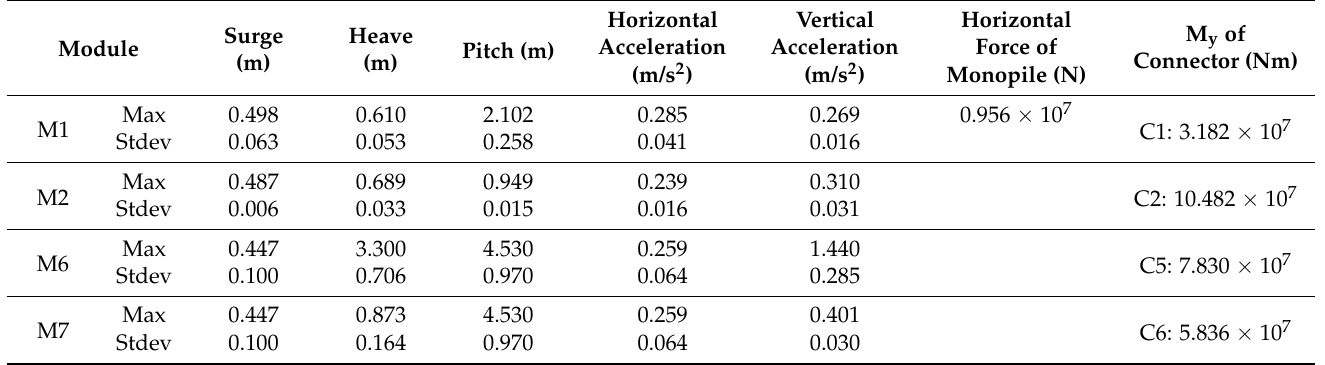
Table 6. Statistic information of the expanded MIFS system under the extreme sea